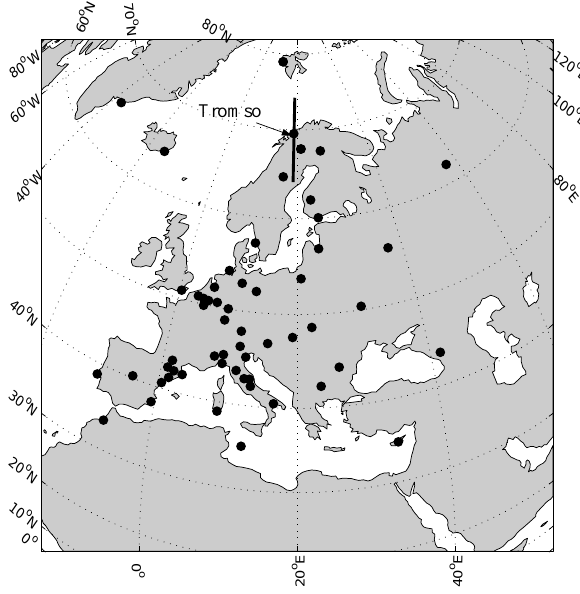
Fig. 1. Map showing locations of GPS receivers and EISCAT radar. The azimuth of the radar scan is shown passing through